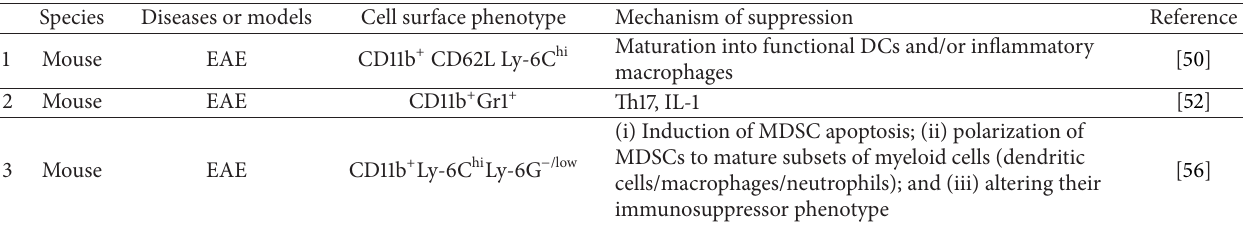
Table 2: Aggressive MDSCs in